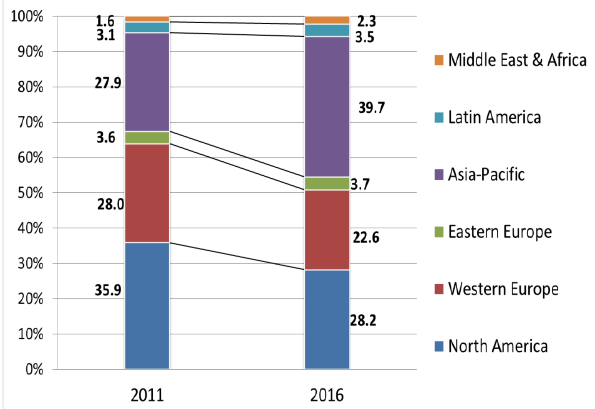
Figure 1. E-commerce sales by region 2011 and 2016